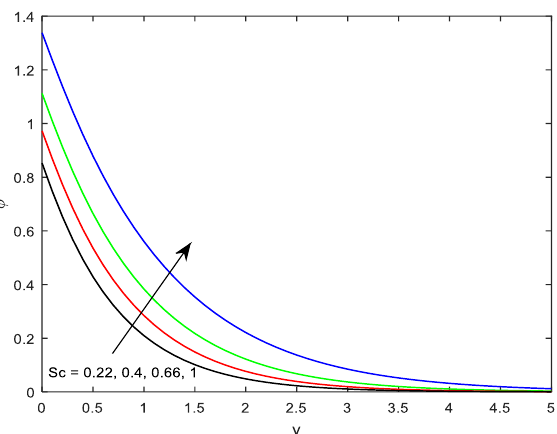
Fig. 10. Profiles of  with a change in Sr